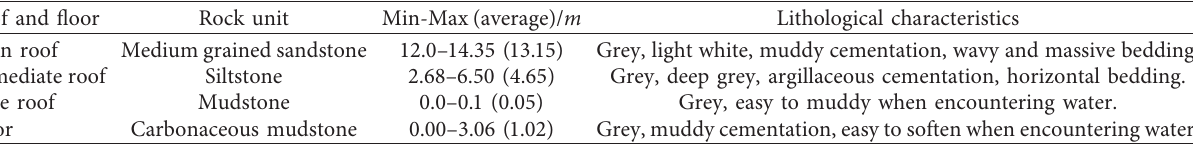
Table 1: Condition of roof and floor.